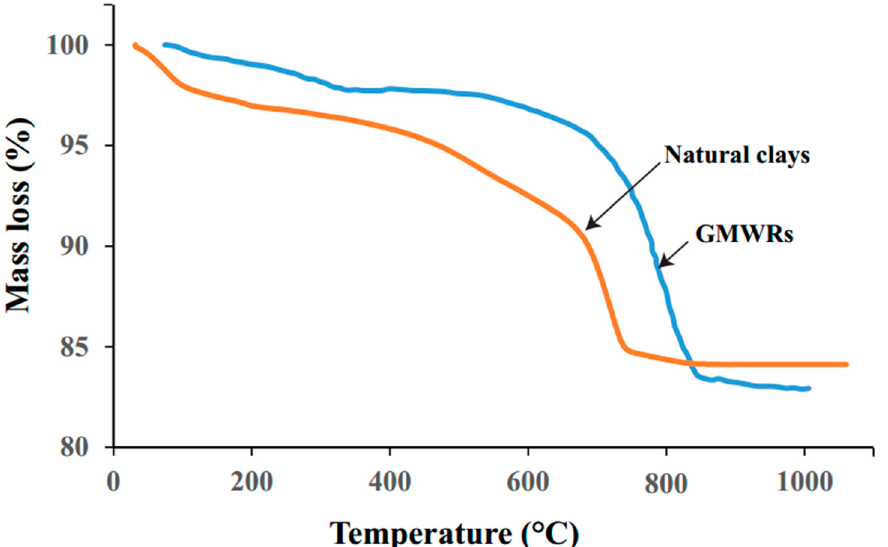
Figure 6. Thermal analysis (TGA) of the NC and GMWRs.